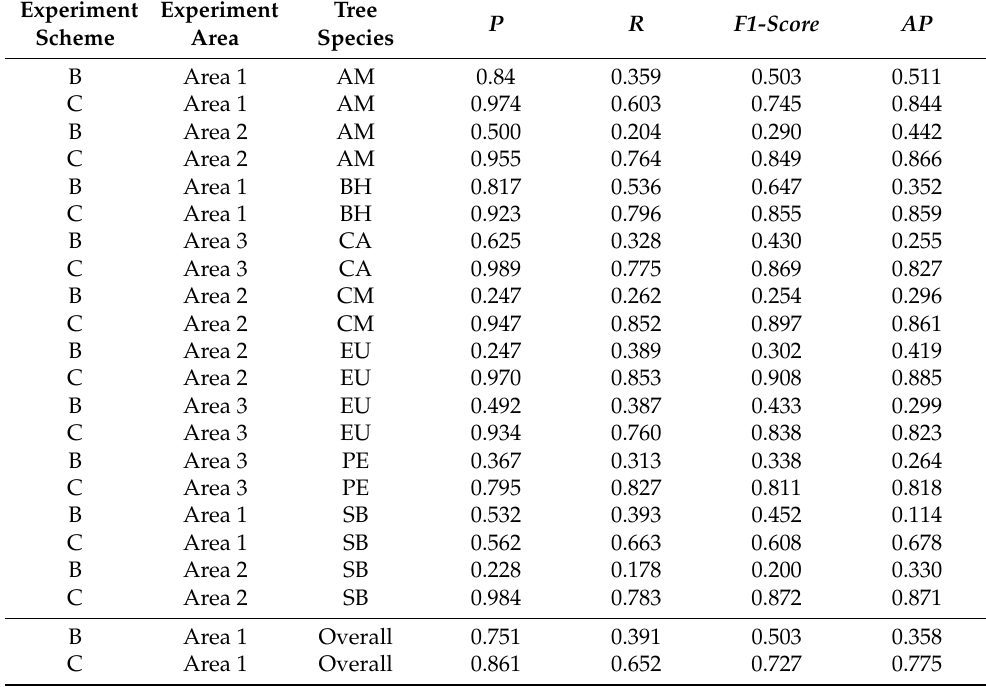
Table 6. Accuracy evaluation of individual tree species identification with different backbone